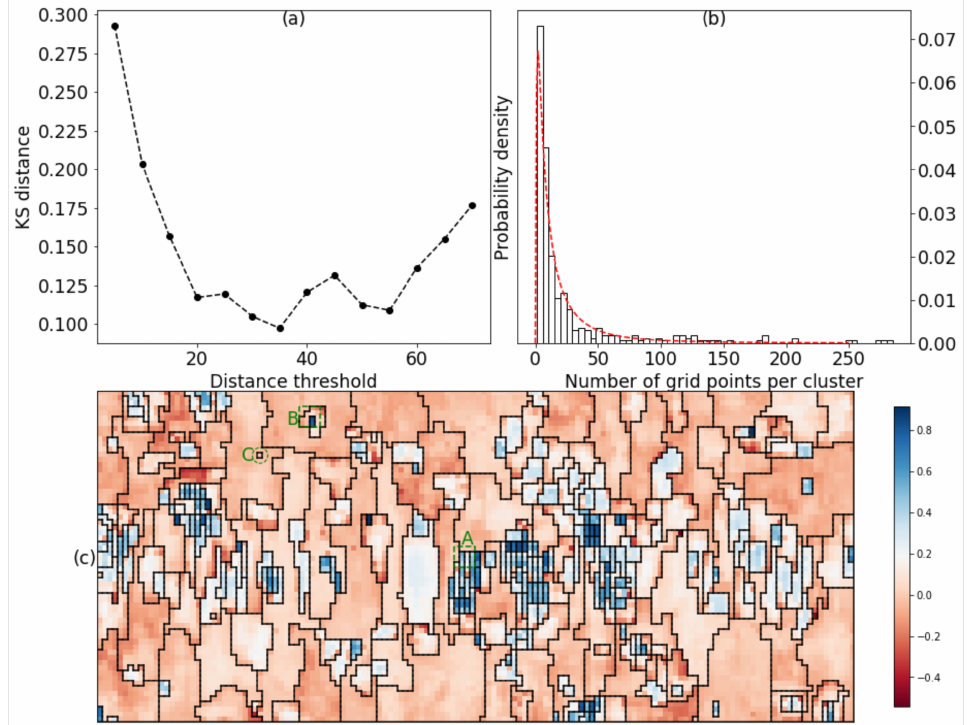
Figure 7. ( a ) the variation of KS distances with the distance threshold; ( b ) the histogram of the grid points per cluster along with the theoretical lognormal probability distribution curve; ( c ) the optimum segmentation result decided from the proposed criterion, the color map is given by the silhouette coefficient distribution, the fatigue loading is along the vertical direction. The grid points were spaced by 2 µ m vertically and